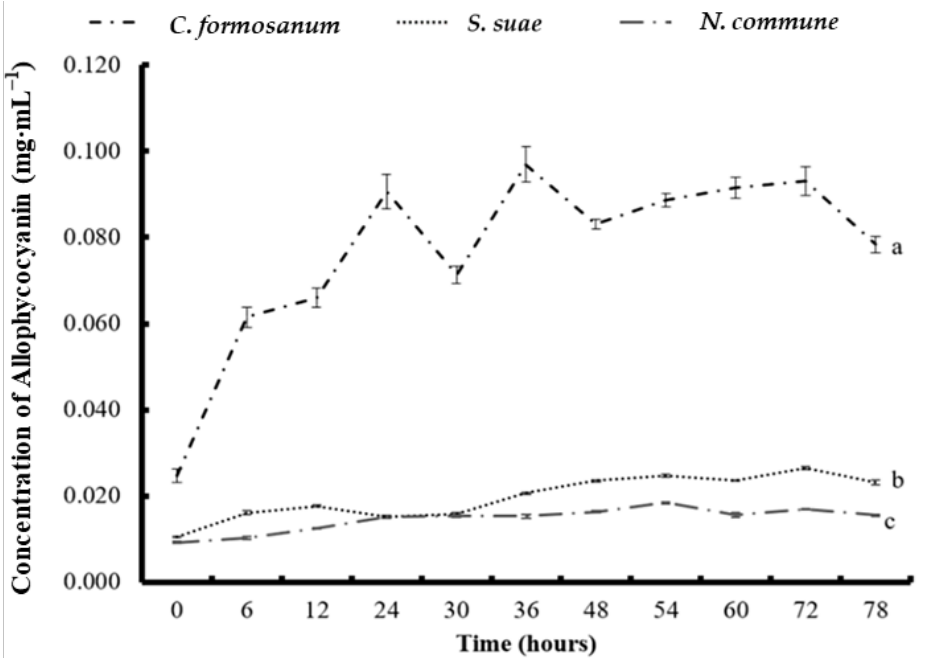
Figure 3. The concentration of allophycocyanin in (a) Colaconema formosanum , (b) Sarcodia suae , and (c) Nostoc commune as substrates fermented with Pseudoalteromonas haloplanktis , ATCC 14393.